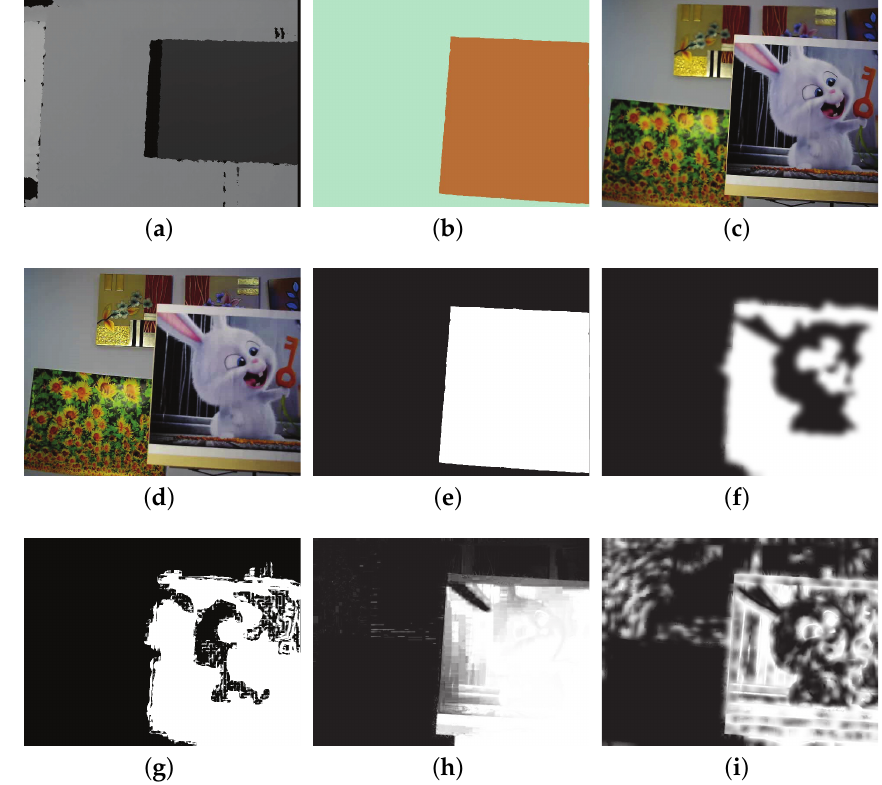
Figure 7. Images of one test scene ( a – d ) and weight maps of different multi-focus image fusion methods ( e – i ). This is the fifth scene in Figure S1 (Supplementary Material). ( a ) Depth map of the scene. ( b ) Segmentation result of the depth map. ( c ) Multi-focus source image with the front object in best focus. ( d ) Multi-focus source image with the background objects in best focus. Weight maps generated by ( e ) our proposed method, ( f ) DCNN, ( g ) dense SIFT (DSIFT), ( h ) image matting